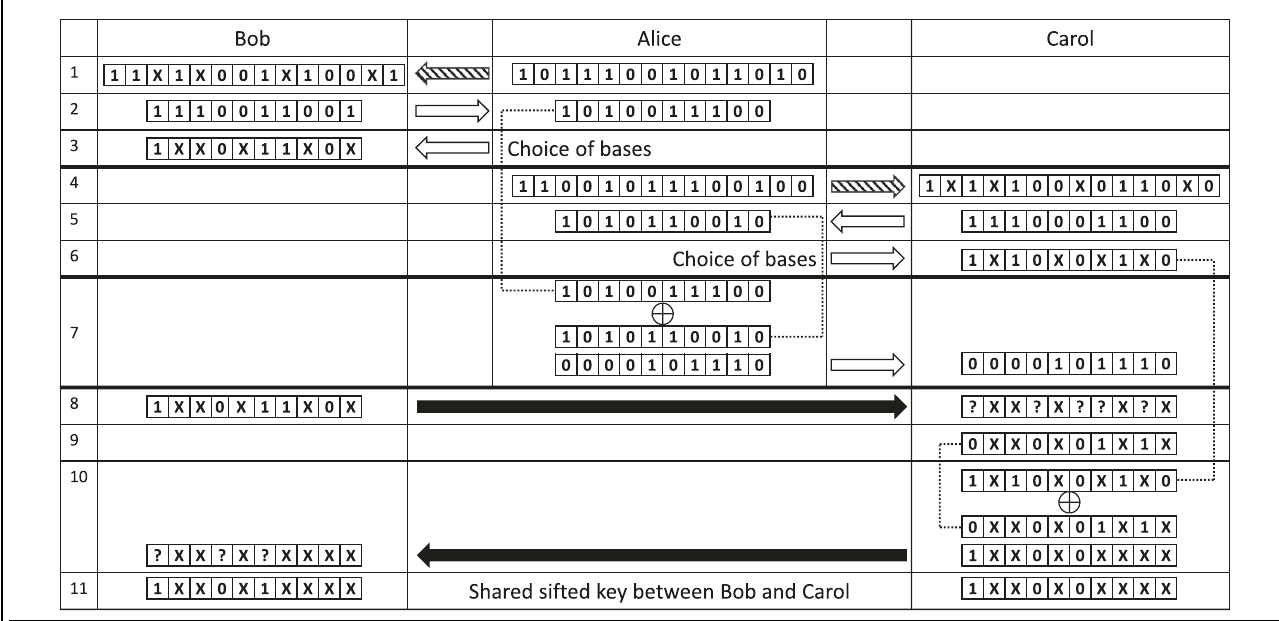
The different steps of the protocol are described below, each item corresponding to the numbered row in the Table. 1. Alice prepares a series of quantum states, according to BB84 polarisation protocol. For each state, she chooses both the bit value and the corresponding basis. She sends the states to Bob over a quantum channel (arrow with diagonal stripes). 2. Many states are lost in the transmission. Bob tells Alice, which states have been lost (X in the table). He uses the classical discussion channel (white arrow). Alice and Bob discard all the corresponding states. The resulting series of bits is the raw key. 3. Alice tells Bob, over the classical discussion channel, which bases she used. Bob notes the cases when he and Alice used different bases (X in the table), but does not tell Alice. The remaining bits represent the sifted key for Bob. Alice cannot know, which of the states were received by Bob in the correct basis. 4. to 6. Alice and Carol follow the same protocol with a new series of states. 7. Alice performs an XOR of the two raw keys she exchanged with Bob and with Carol and sends the result to Carol, over the classical discussion channel. 8. Bob sends directly to Carol, which bits he received in the wrong basis and should not be used (X in the table). He uses a con fi dential classical channel, which cannot be eavesdropped by Alice (black arrow). 9. Carol notes the wrong bits in the XORed